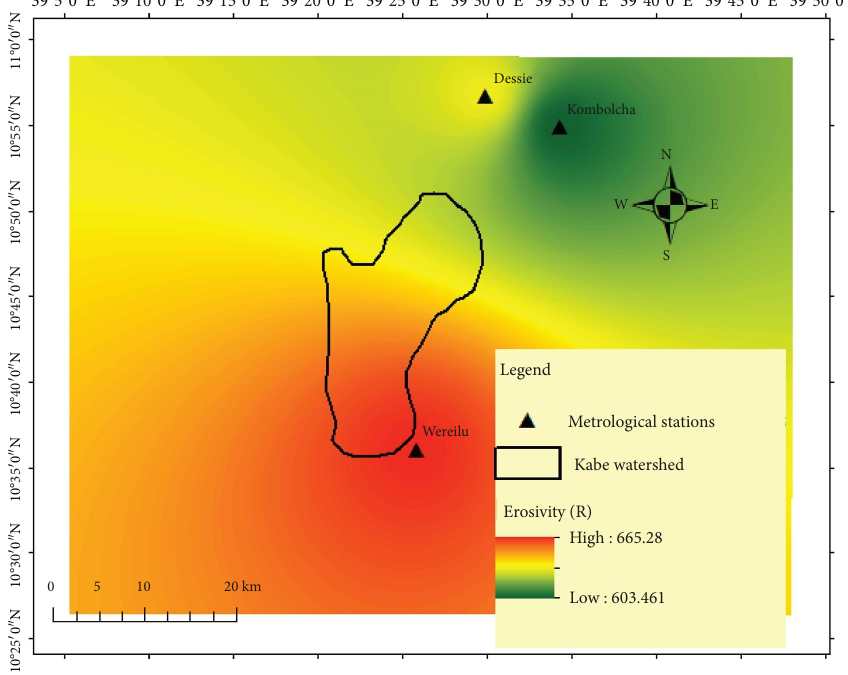
Figure 3: Erosivity ( R -Factor) map of Kabe